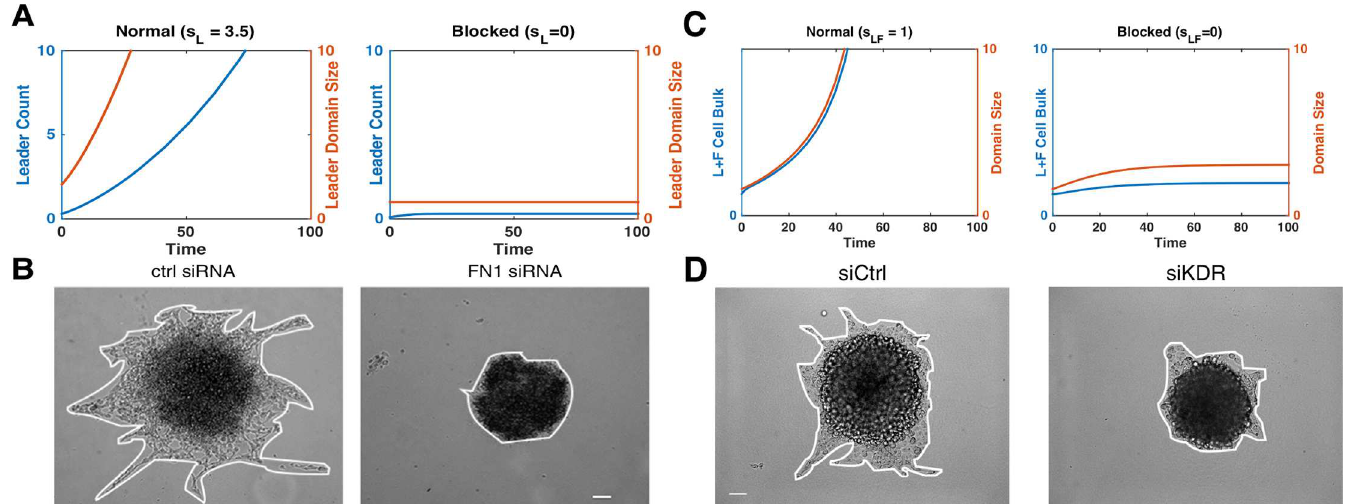
Fig 5. Model reproduces in vitro experimental results. A) In the model, leader cell count (blue) and domain size (red) are given in both normal (left) and leader population feedback, s L , blocked (right) conditions. B) In cell culture, invasion of leader cells was significantly reduced during siRNA block of focal adhesion kinase (right), compare to control (left). Scale bar 100 μ m. Reproduced from [14]. C) In the model, blocking leader to follower feedback, s LF , limited invasive area and cell count. D) Impact on invasion of leader cell cultures during siRNA block of VEGFR2 (siKDR). Scale bar 100 μ m. Invasive area was significantly reduced after VEGFR2 block (p < 0.0001) (right), compare to control (left). Reproduced from [14].